Question: Generate an informative caption for the figure above.
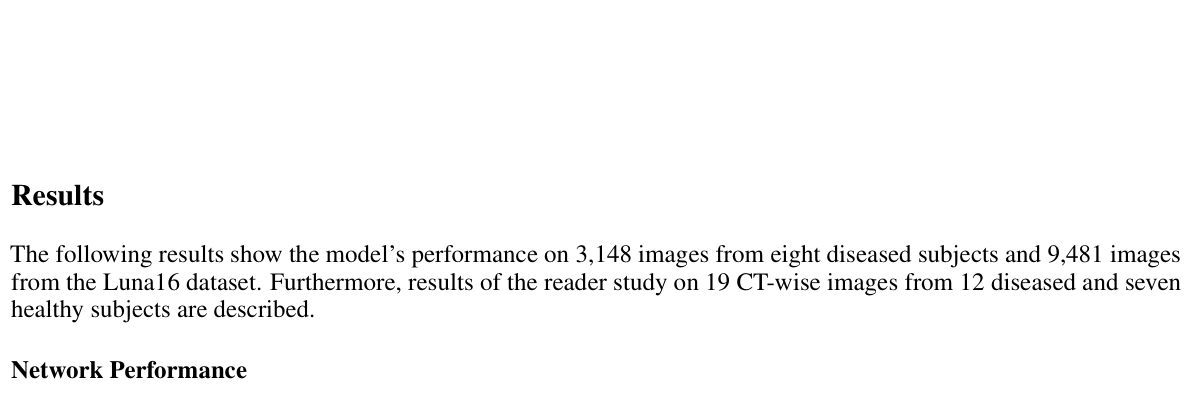
Answer: shows an example slice with varying levels of subsampling alongside the corresponding U-Net postprocessed results. It can be observed that fewer projection views result in more artifacts. The sparse-view images from extremely limited views also lead to a loss of structural integrity in their postprocessed counterparts. This was especially prominent for 16 views, as metastatic lung nodule distortion and microvascular structures generate diminished performance capabilities. metastatic nodule composition and primary anatomical characteristics can better be amassed once reconstruction views have increased to 32. For 64 views, streak artifacts did not impact the nodule’s visibility due to tissue density, but minimalistic structural identification, such as small vessels, are not clearly portrayed. Minor features were displayed for 128 and 256 views; however, for 128 views, some streak artifacts remained present. For the postprocessed image of 32 views, the nodule shape was mostly corr